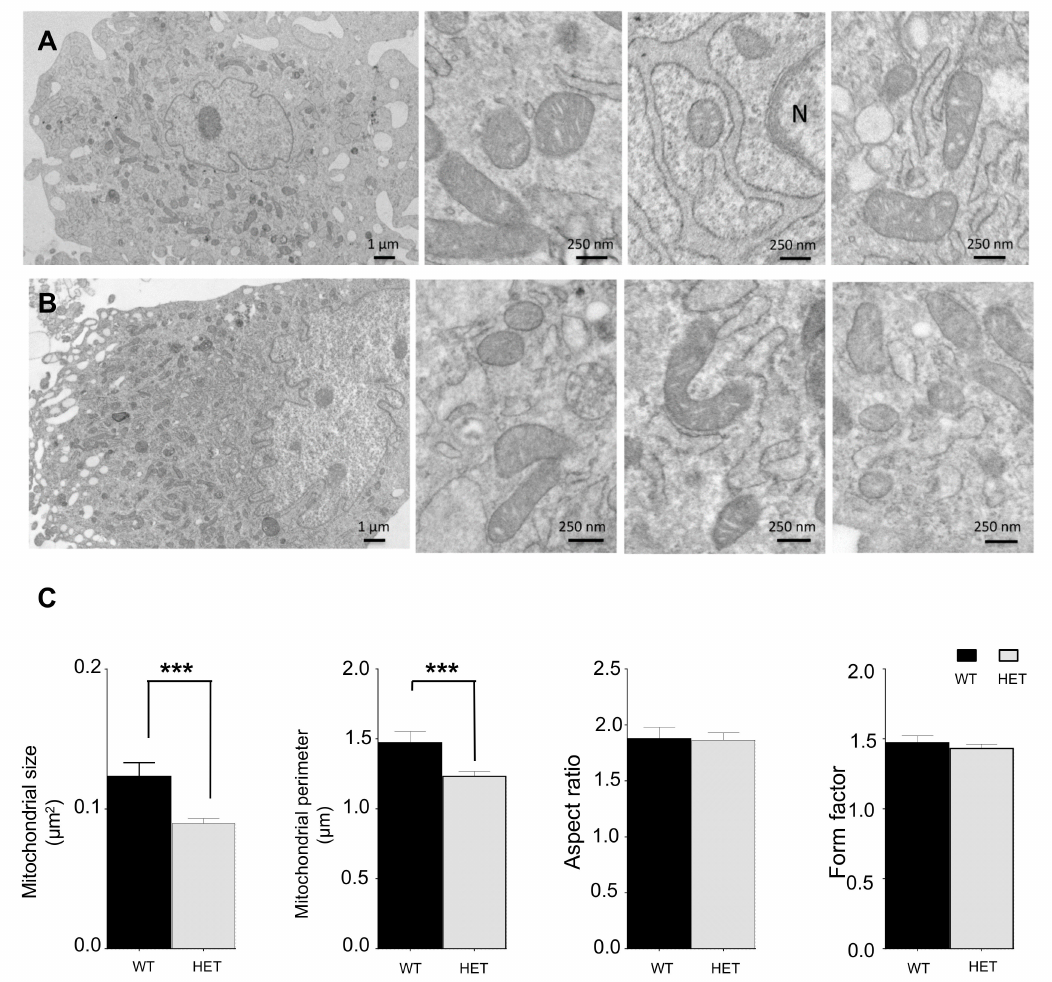
Figure 5. Ultrastructure analysis of mitochondria morphology of MEFs of wt and het mouse. Electron microscopy images of MEFs from wt ( A ) and het mouse ( B ). ( C ) Analysis of mitochondrial size, perimeter, aspect ratio and form factor. Wt n = 68, Het n = 192. Data are expressed as mean ± SEM. *** p <